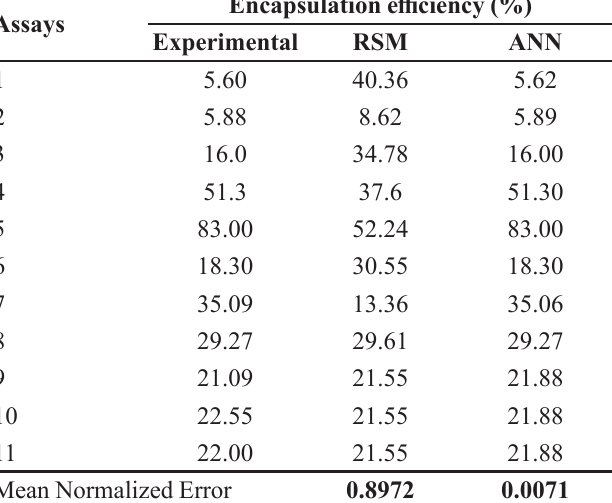
TABLE V - Comparison between experimental data and predictive models generated by RSM and ANN. Data associated with Equation 5